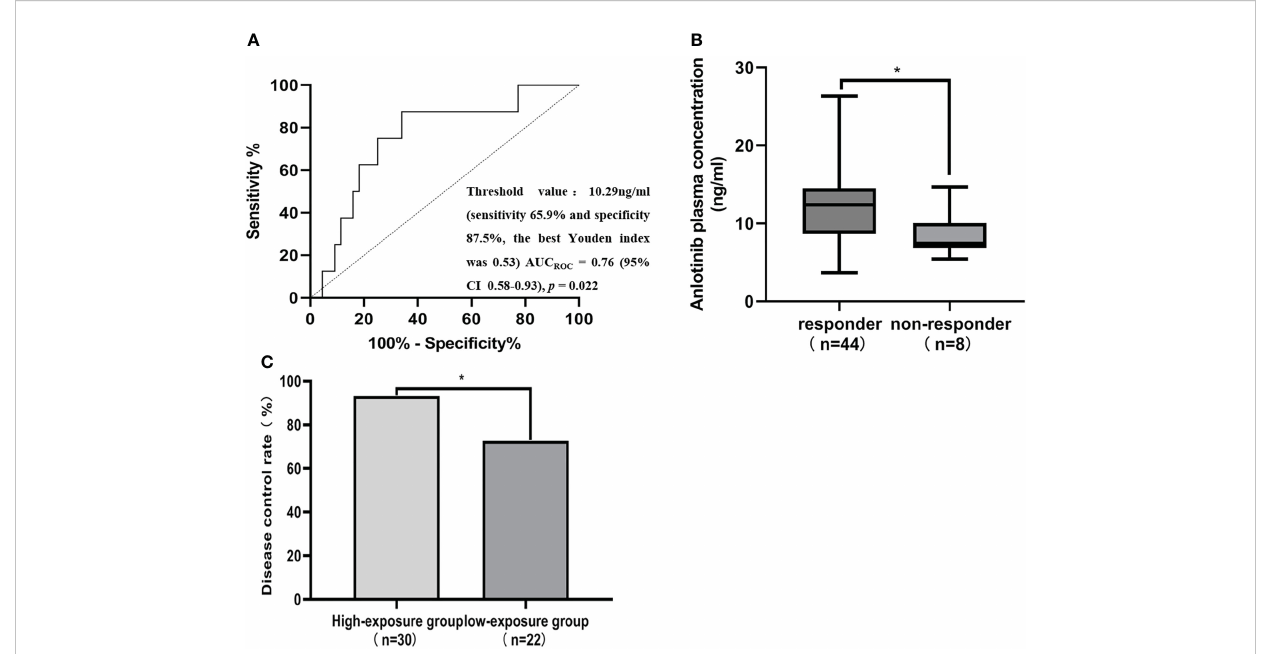
FIGURE 3 ANL C trough threshold for responder and disease control rate (DCR). (A) Receiver operating characteristics (ROC) curves for predicting responder status. AUC ROC area under the receiver operating characteristic curve, CI Con fi dence interval. (B) Comparison of ANL C trough between patients with responder and non-responder. Responders were de fi ned as the patients with CR and SD at best response, while non-responder were de fi ned the patients with PD at best response. (C) Comparison of the DCR between patients with a median ANL C trough ≥ 10.29 ng/ml (high-exposure group) and <10.29 ng/ml (low-exposure group), * represents